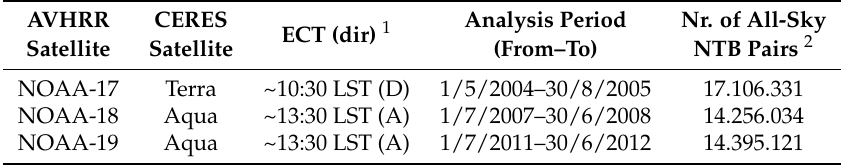
Table 1. Specifications for database with matched NTB pairs.